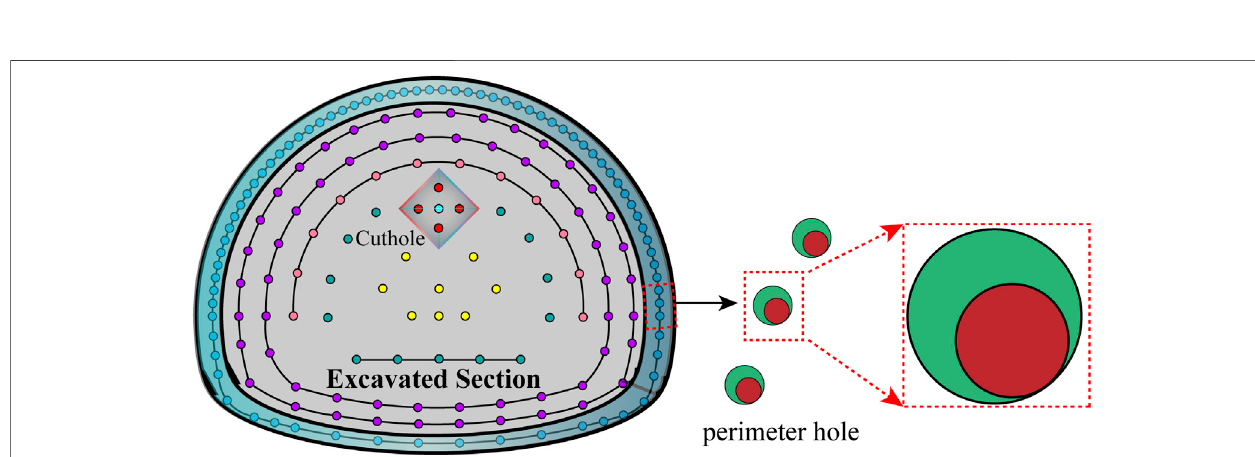
FIGURE 9 | Asymmetric charge structure.